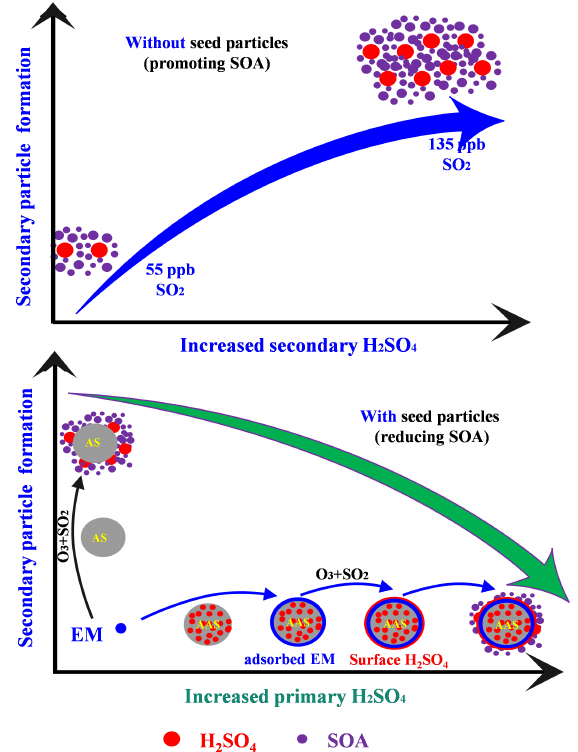
Figure 7. Proposed the role of H 2 SO 4 formation on EM-derived